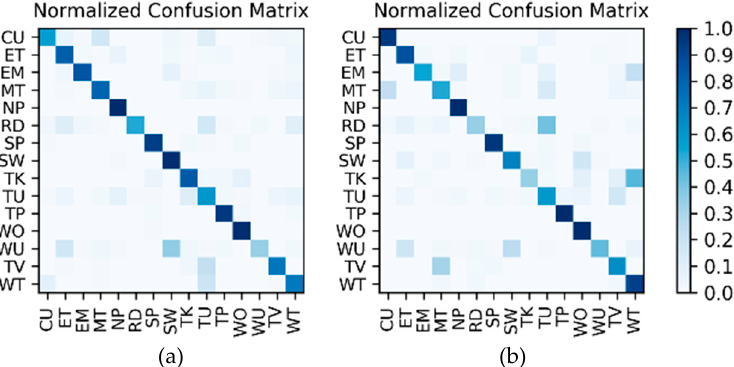
Figure 18. Confusion matrices for the direct fusion results: ( a ) W1; ( b ) W2. Table 11. F 1 accuracy of the direct fusion results.